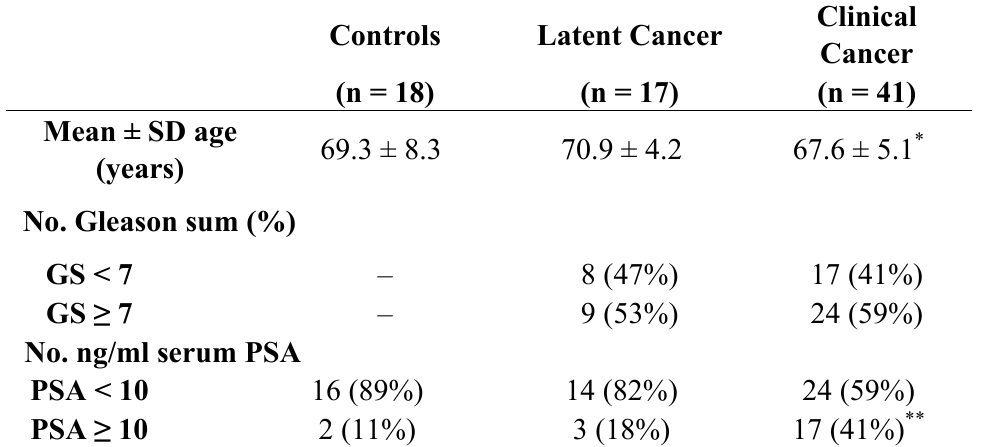
Table 1. Characteristics of Clinical-and Latent-Prostate Cancer Patients and